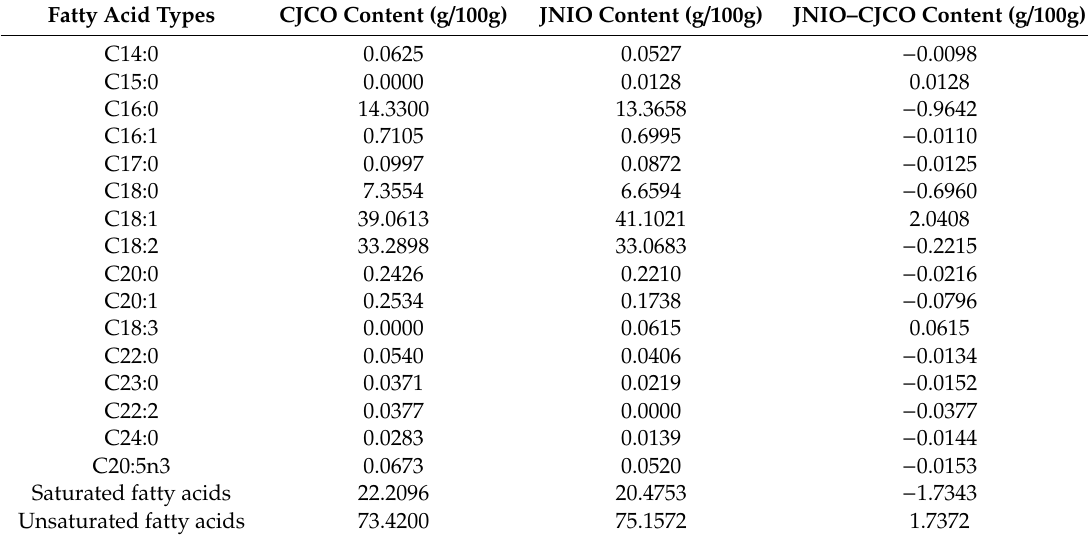
Table 4. Fatty acid composition of CJCO,